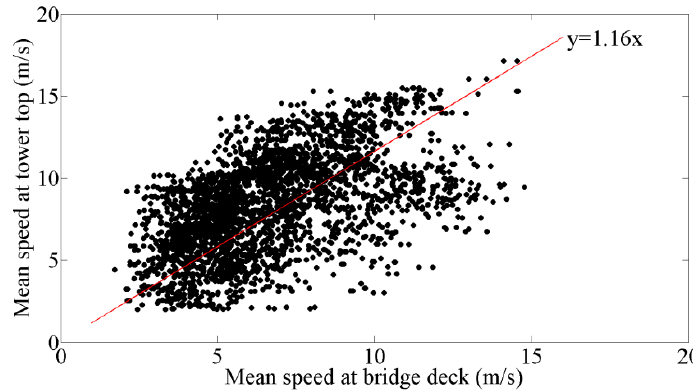
Figure 14. Correlation between mean wind speeds at tower top and deck level of the bridge.